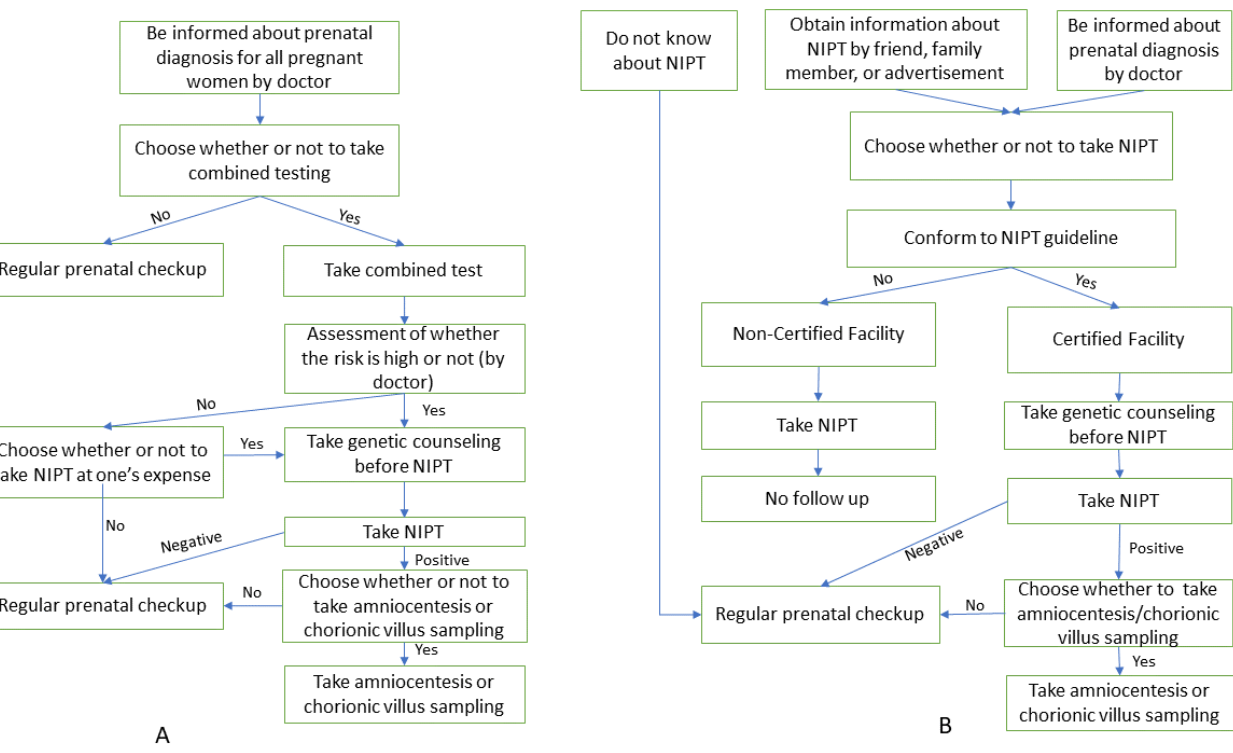
Figure 1. The process of NIPT in Japan and other countries. ( A ) Process of NIPT in other countries; ( B ) Process of NIPT in Japan.